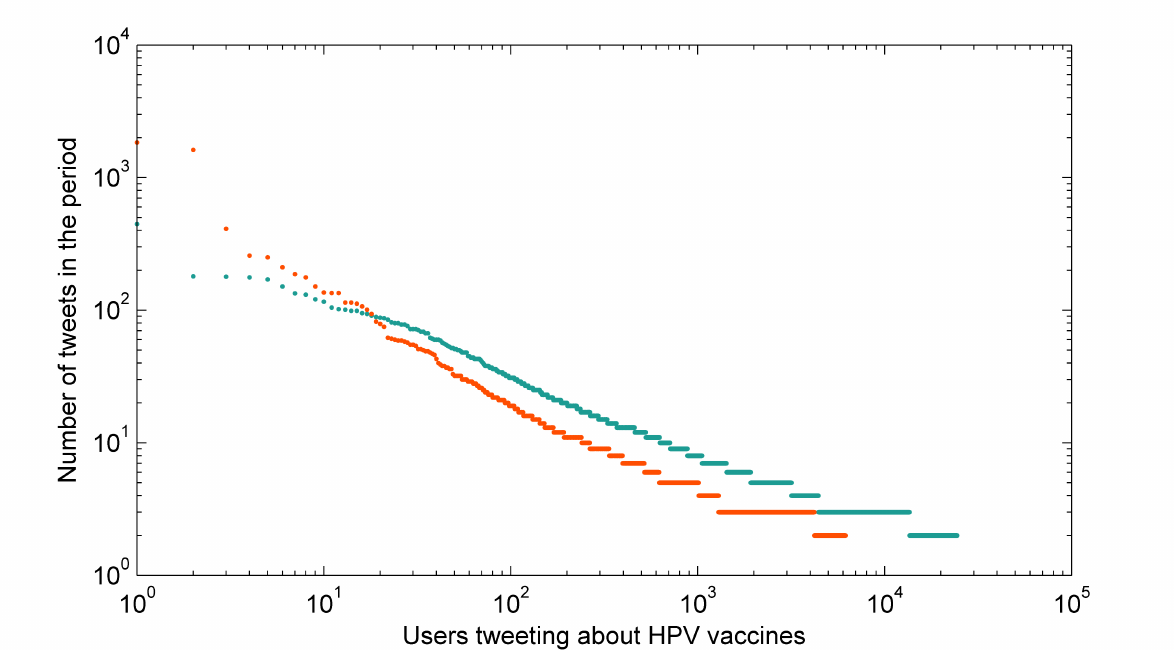
Figure 2. The ordered distribution of tweets per user related to HPV vaccines posted to Twitter between October 1, 2013 and March 31, 2014. Each user’s number of tweets is represented by a dot and illustrated separately for users that posted a majority of negative tweets (orange) and all other users